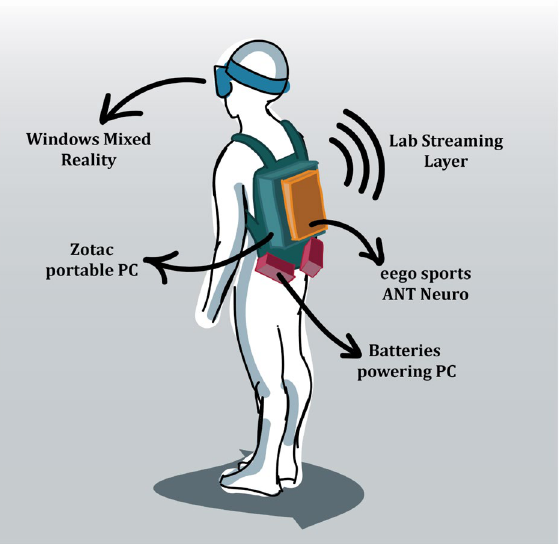
Figure 2. The illustration depicts the MoBI setup used during the experiment. The participants wore a backpack, carrying a high-performance gaming computer (Zotac, blue), powered by two batteries (red). An EEG amplifier (ANT eegoSports, yellow) was attached to the backpack and connected to the computer. The participants wore a VR head-mounted display (Windows Mixed Reality) on top of a 64-channel cap. This setup allowed participants to move freely around while recording